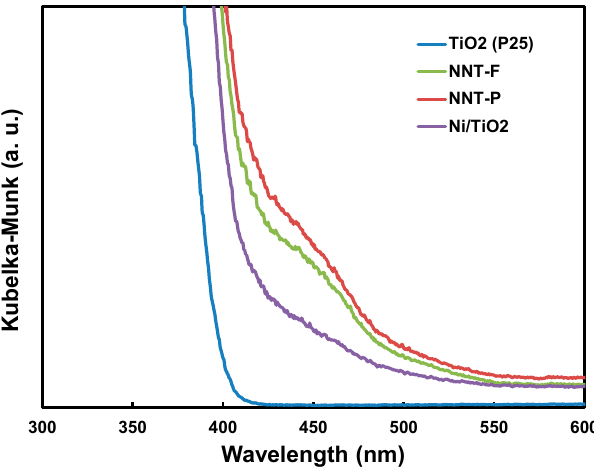
Figure 8. UV-visible diffusion reflectance spectroscopy (DRS) spectra of TiO 2 (P25), Ni/TiO 2 , and N- and Ni-coated TiO 2 (NNTs).